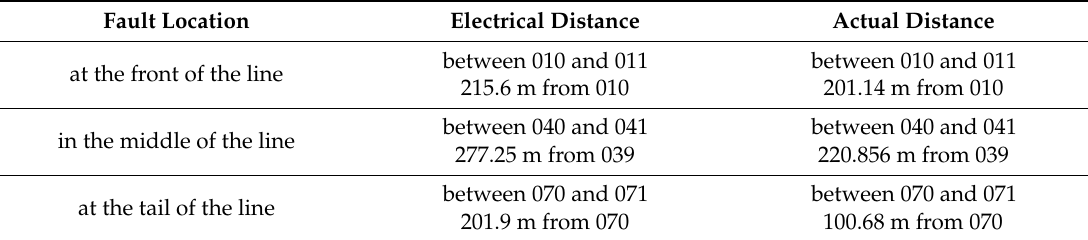
Figure 7. A line-mode traveling wave waveform in the electrical distance model when faults happen ( a ) in different parts of the line, ( b ) in the middle of the line, and ( c ) at the tail of the line. Table 1. Comparison of fault location results from the electrical and actual distance models.